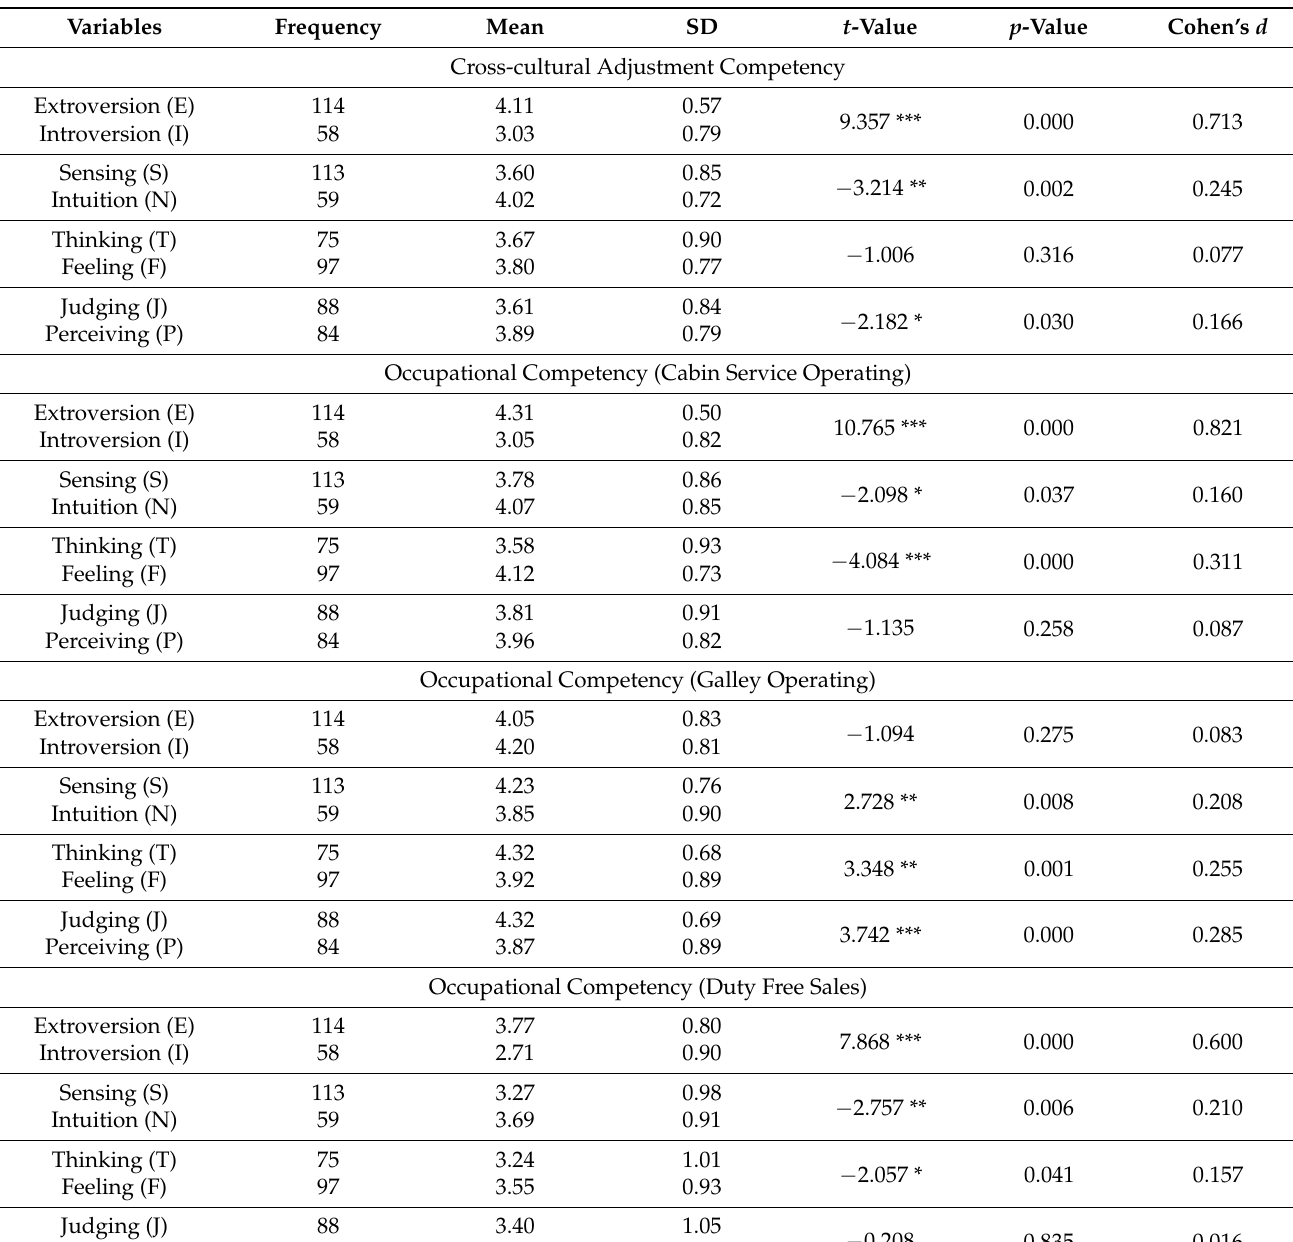
Table 2. t -test for cross-cultural adjustment competency, occupational competency, and coping